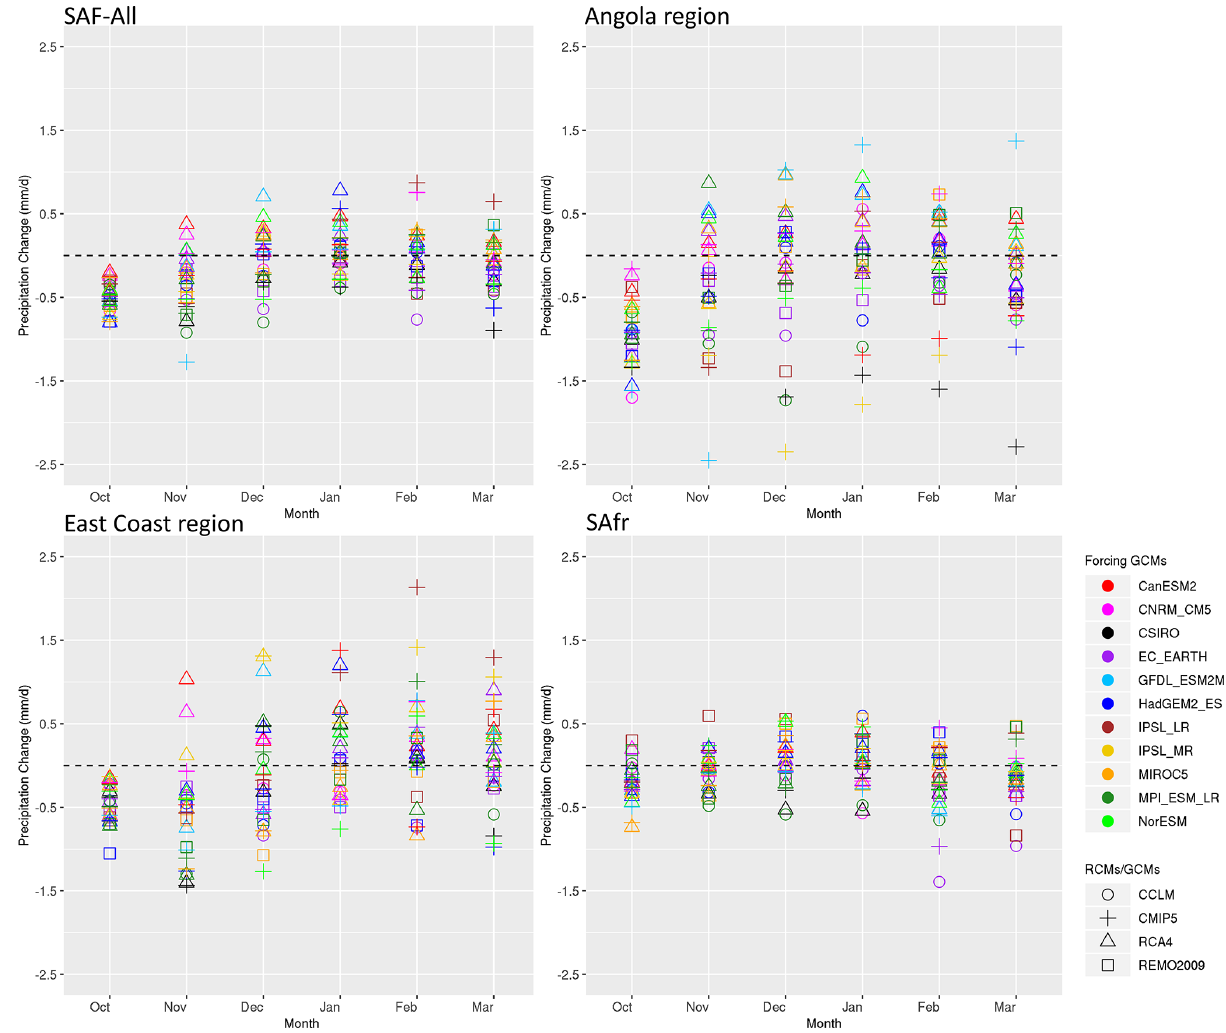
Figure 13. Spatial average of the precipitation change signal (mmd − 1 ) from RCMs and their driving GCMs relative to 1985–2005 for southern Africa and the three sub-regions